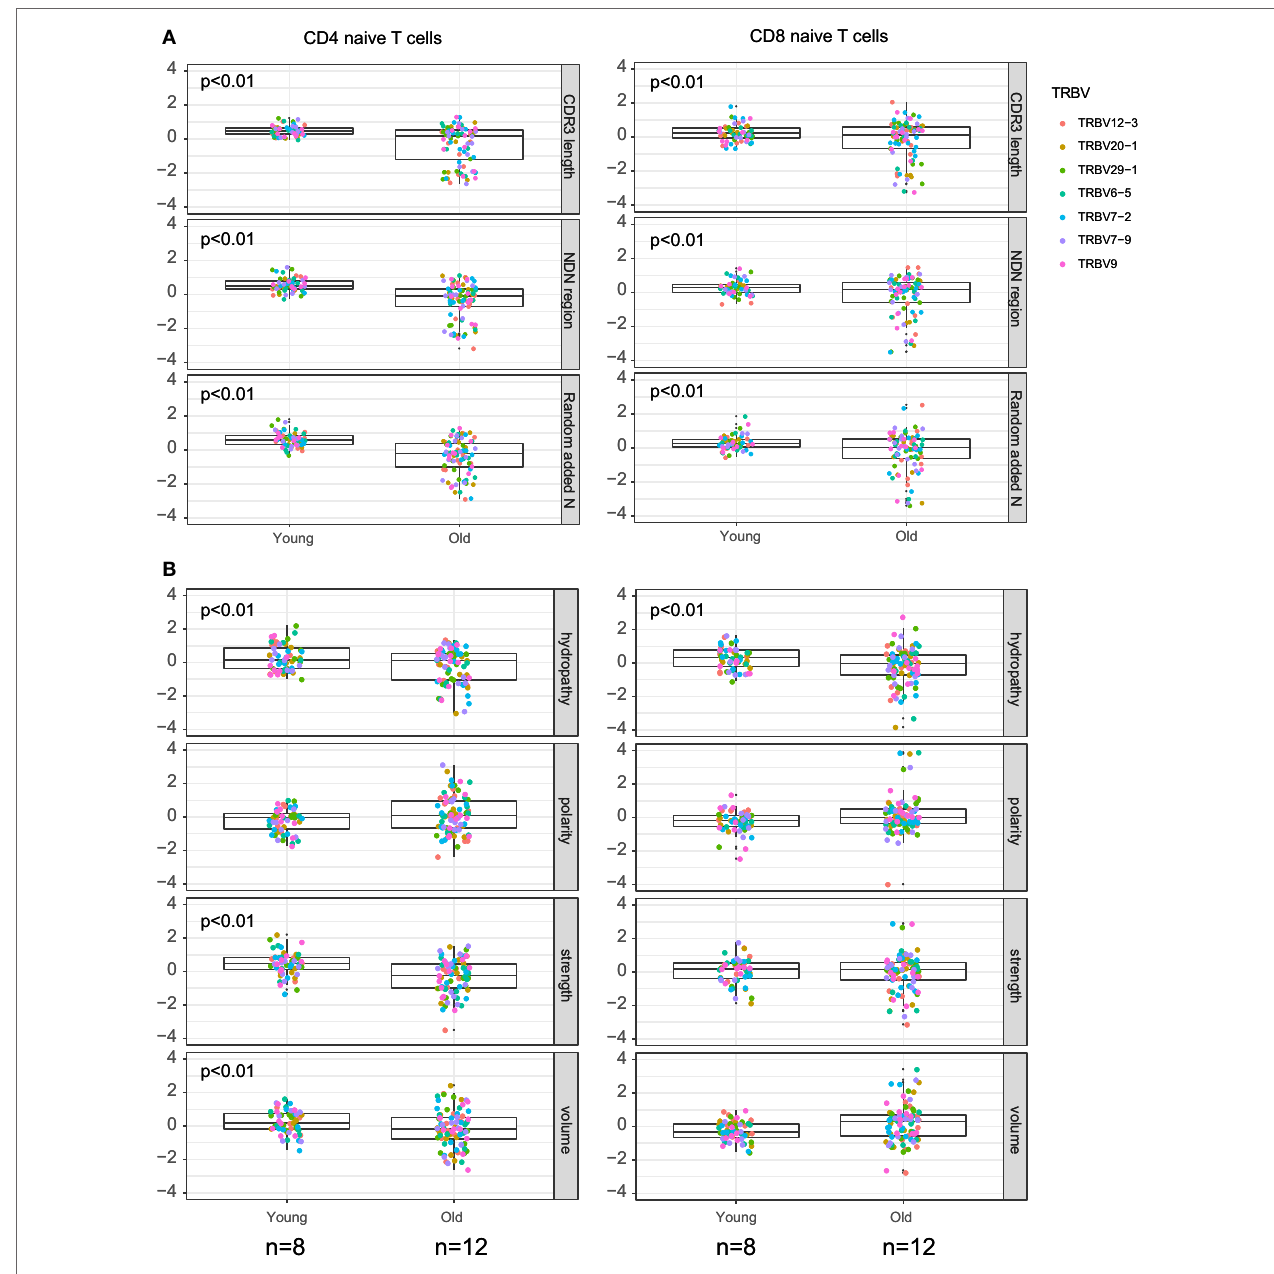
FigUre 3 | Properties of naïve T cell T-cell receptor (TCR) beta CDR3 repertoires and aging. Weighted (accounting for clonotype size) analysis of TCR beta repertoires properties for CD4 and CD8 naïve T cells derived from peripheral blood samples of young and old healthy donors. (a) Average CDR3 length, size of NDN insert, and count of randomly added N nucleotides. (b) Amino acid composition within 5 amino acid residues in the middle of CDR3. Our data and Qi et al. data, n = 8 young and 12 old individuals totally. CDR3 repertoires for the seven largest TRBV segments were analyzed separately, with Z -score normalization to account for TRBV-specific